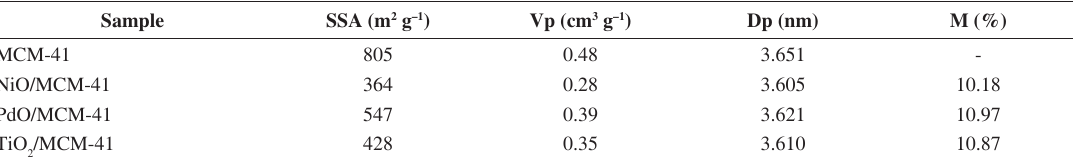
Table 2. Textural properties and chemical composition of MCM‑41, NiO/MCM‑41, PdO/MCM‑41 and TiO SSA = specific surface area; Vp = pore volume; Dp = pore diameter; M (%) = Ni, Pd or Ti (%).